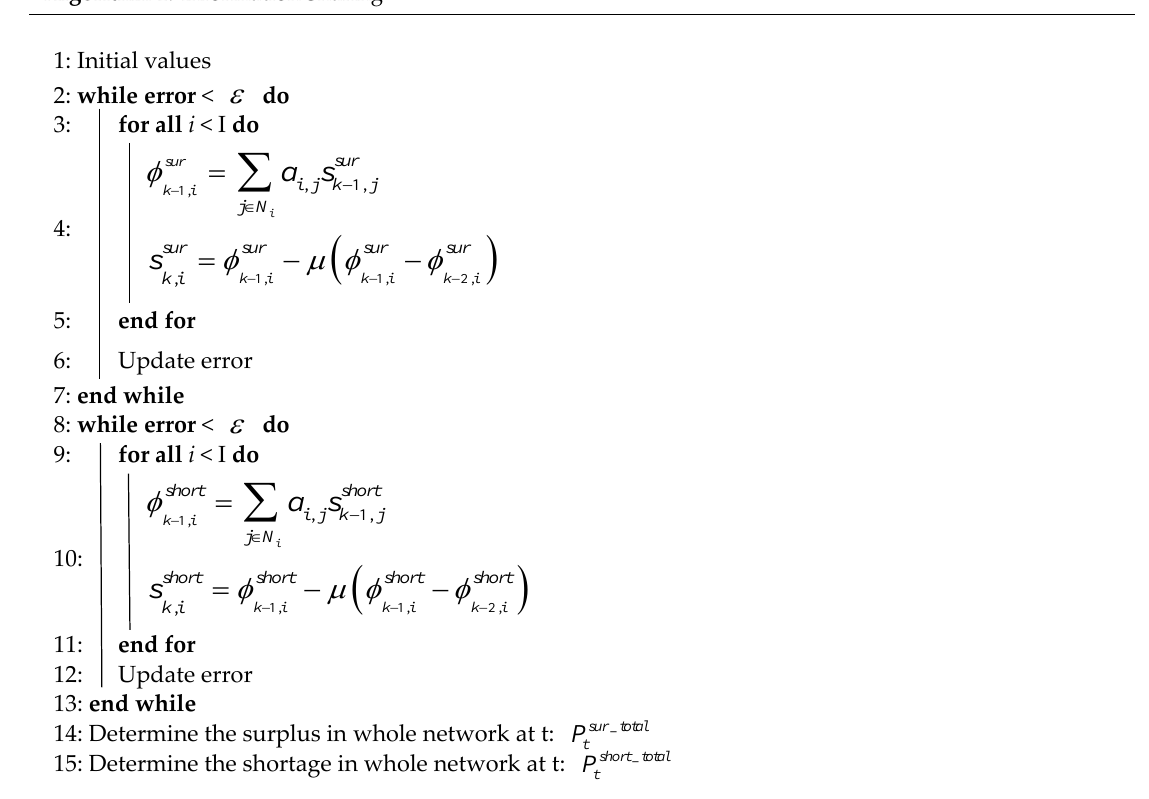
Algorithm 1: Information Sharing